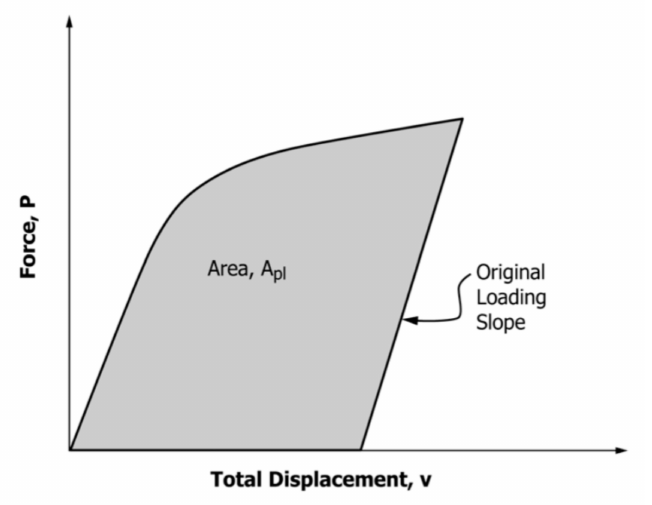
Figure 4. Definition of the area for the J calculation using the basic